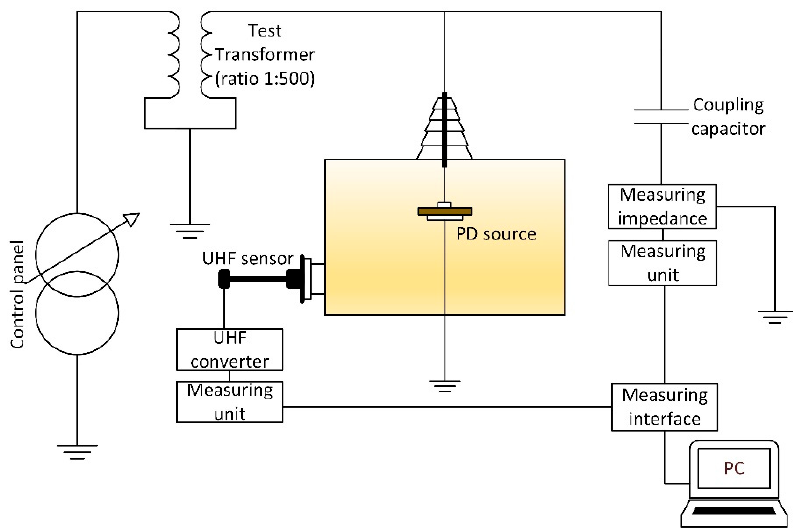
Figure 1. Layout of the measurement setup.